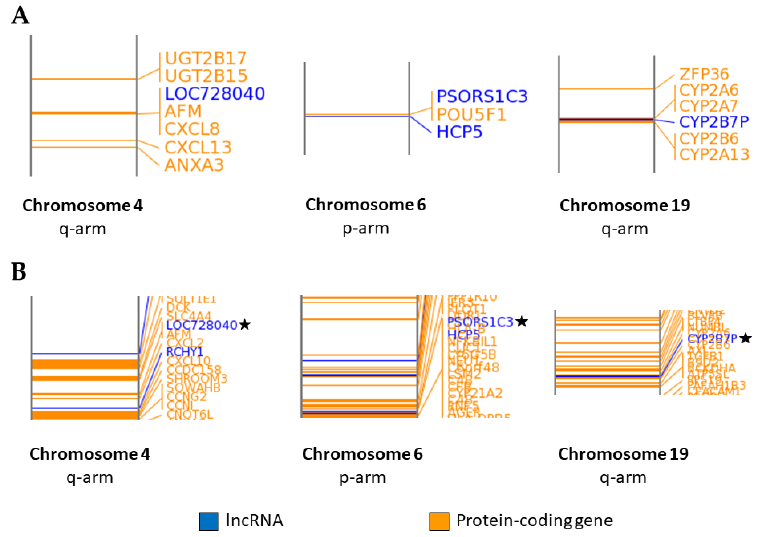
Figure 4. Chromosomal location of lncRNA genes within 1000 kb of protein-coding genes with differentially expressed transcripts after primary human hepatocytes were exposed to 100 µM DEET or 10 µM fipronil. ( A ) Location of dysregulated lncRNAs and neighboring (within 1000 kb) protein-coding genes affected by 100 µM DEET on selected chromosomes and ( B ) location of dysregulated lncRNAs and neighboring protein-coding genes affected by 10 µM fipronil on selected chromosomes. p-arm = short arm of chromosome; q-arm = long arm of chromosome; black star = corresponding lncRNA from 10 µM DEET treatment.